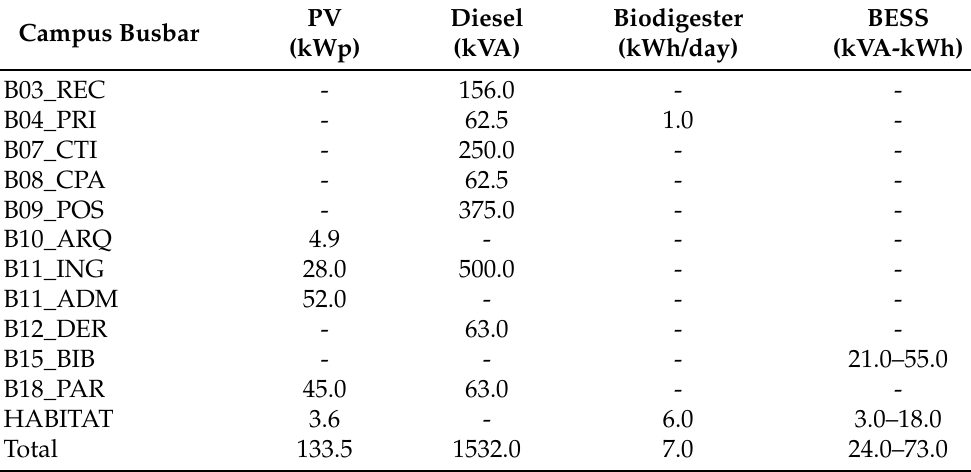
Table 2. UPB microgrid distributed energy resources